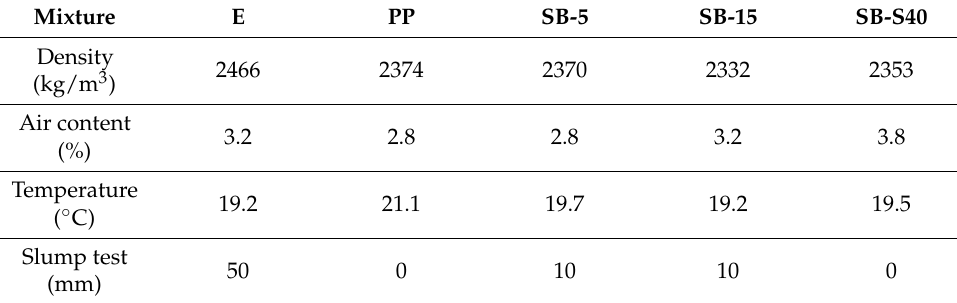
Table 3. Properties of fresh concrete